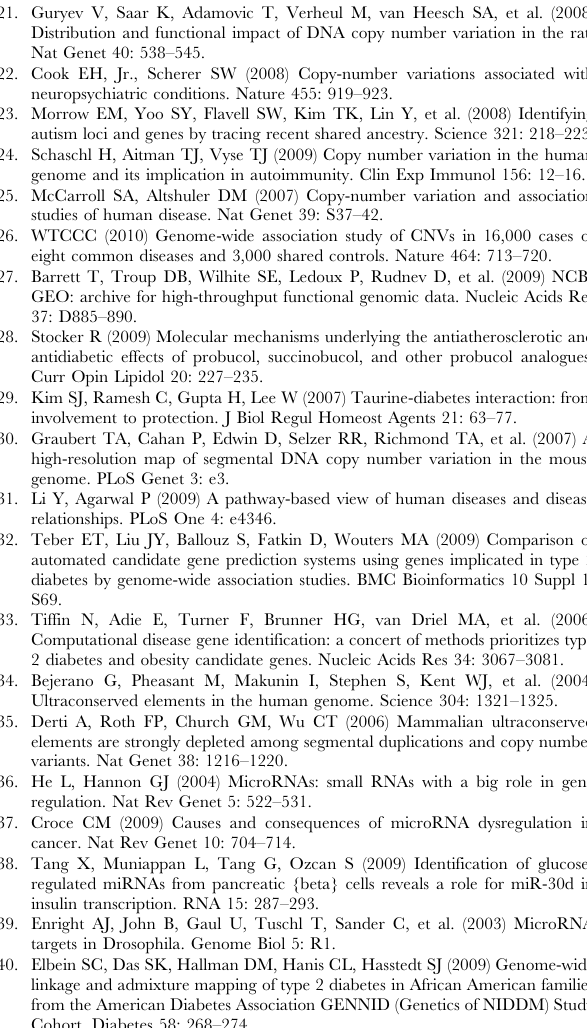
Table S11 Pathway mapping and enrichment of the targets of rno-mir-30d.